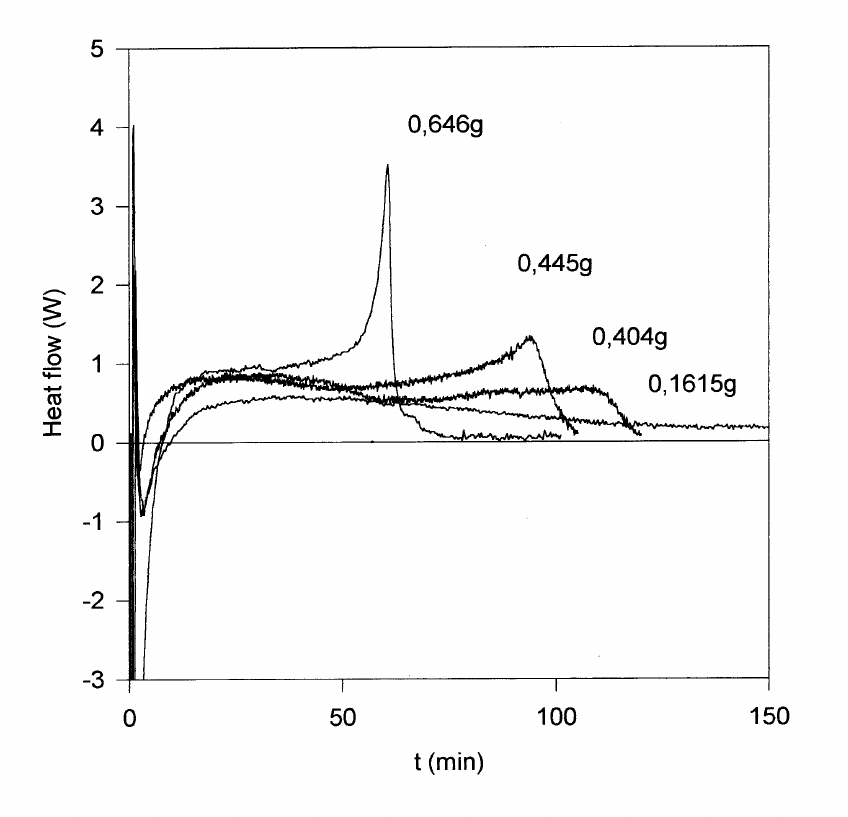
Figure 2. Heat flow - time curves for the emulsion polymerization of styrene with varying amounts of 3b